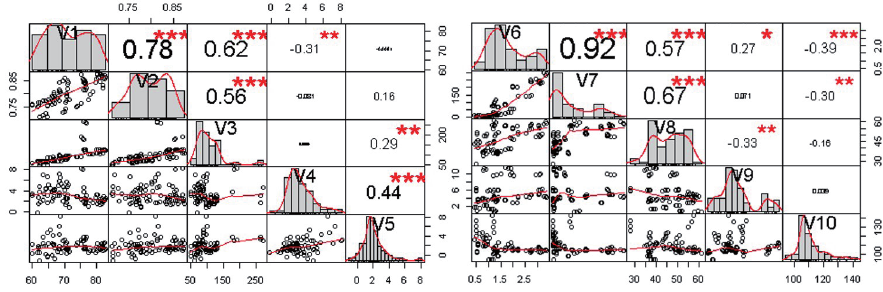
Fig. 2 – Correlations: within set X (left) and within set Y (right). Source: own research From the left side of Figure 2, we can note that the highest correlations are seen between GCI (V1) and IHDI (V2) and GDP per capita ranging from 0.78 (V1 vs. V2), 0.62 (V1 vs. V3) to 0.56 (V2